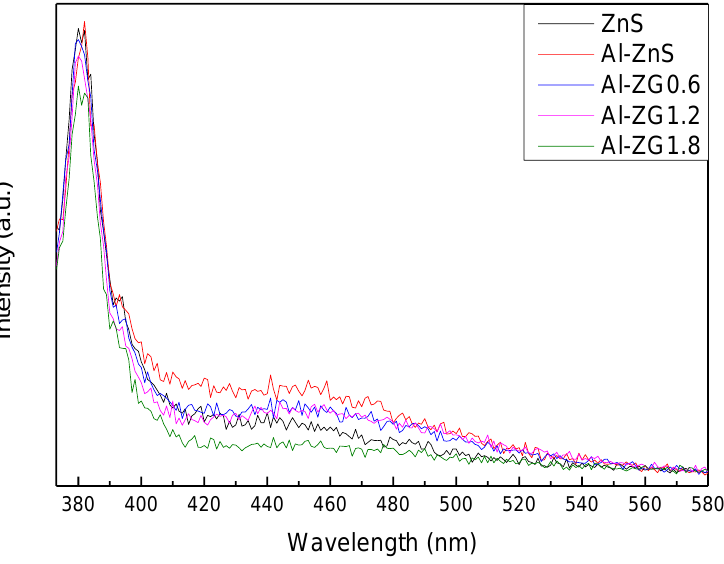
Figure 5. PL spectra of ZnS, Al-ZnS, Al-ZG0.6, Al-ZG1.2 and Figure 5 PL spectra of ZnS, Al-ZnS, Al-ZG0.6, Al-ZG1.2 and Al-ZG1.8.